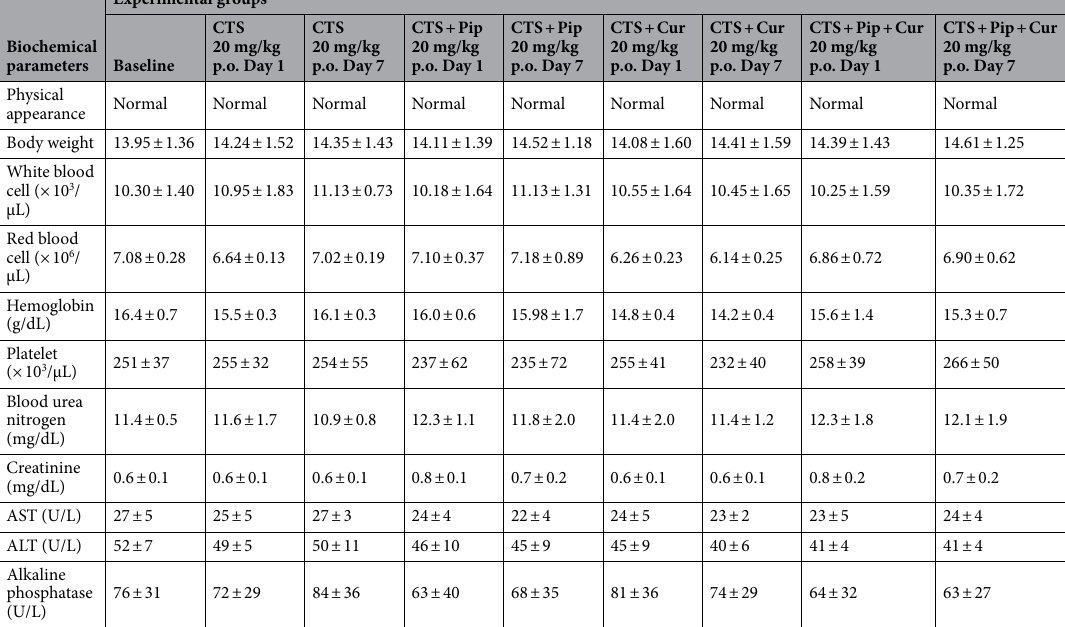
Table 1. Physical and biochemical profiles of experimental beagles. AST aspartate transaminase, ALT alanine transaminase, CTS Centell-S, Pip piperine, Cur curcumin. Data are expressed as mean ± SD, (n = 4); * p < 0.05 for significant differences. Decimal numbers were reported according to laboratory standard of Small Animal Hospital, Faculty of Veterinary Science, Chulalongkorn